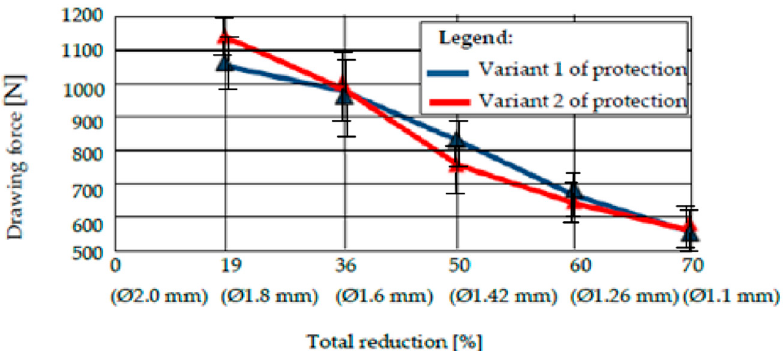
Figure 11. The drawing force of protection variants 1 and 2 for a deformation angle 2· α = 10°.